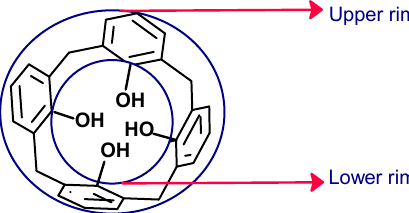
Figure 3. Upper rim and the lower rim on the cavity of the calix[4]arenes .